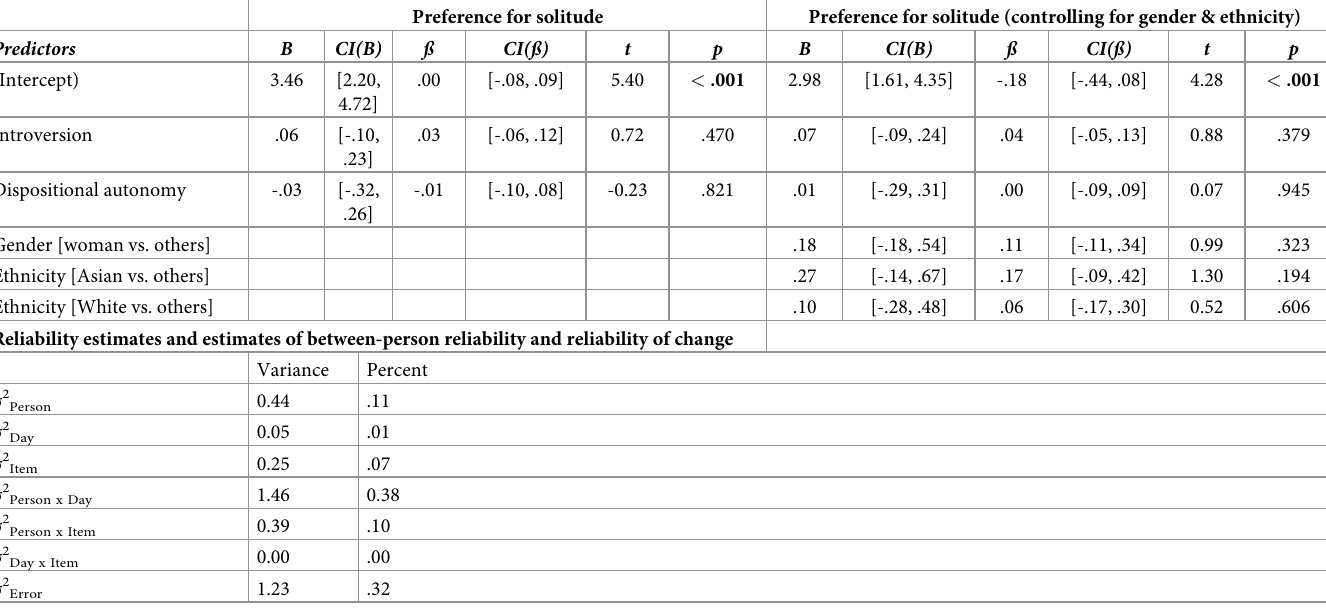
Table 2. Random-intercept models that include introversion and dispositional autonomy predicting daily preference for solitude (Study 1). Preference for